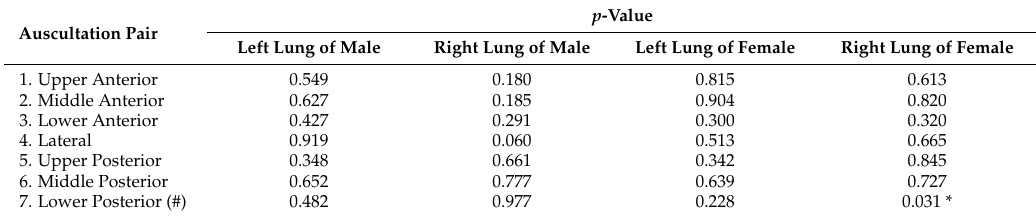
Table 3. Linear regression analysis of the correlation between BMI and the P T at each auscultation site for male ( n = 23) x and female ( n = 18) subjects.